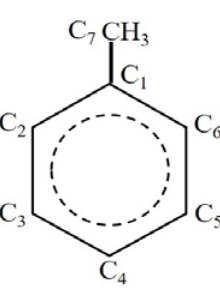
Figure 1. The naming rule for carbon atoms in toluene for this study.